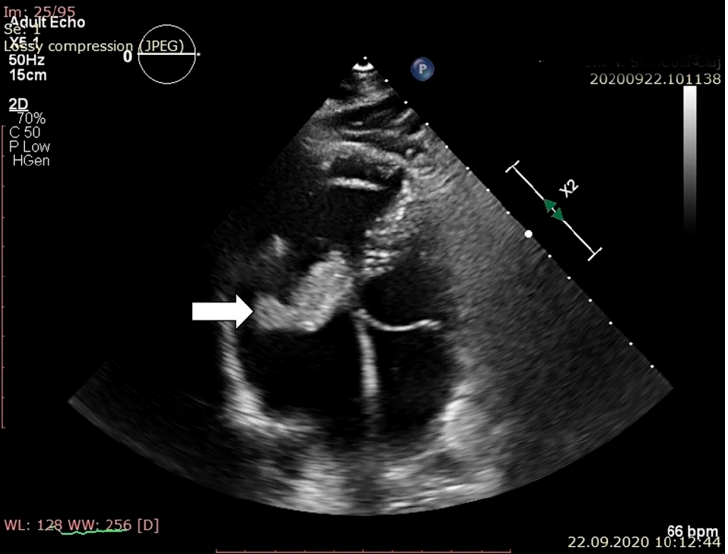
Figure 2. Apical 4 chamber view. Systolic prolapsed in the right atrium of the septal leaflet and vegetation. Laboratory tests revealed a low-grade, chronic inflammation (erythrocyte sedimenta- tion rate) ESR 35 mm/h, C reactive protein CRP 14.92 mg/L, range ≤ 5 mg/L, fibrinogen 411 mg/dL, range 200–400 mg/dL), leukocytosis (white blood cell WBC 11.73 × 10 3 / µ L) anemia (Hb 9.8 g/dL), thrombocytopenia (26,000/ µ L then 18,000 µ L), a prolonged partial thromboplastin time (APTT 46.9 s, range ≤ 36 s), elevated D-dimers (1278 ng/mL, range <250 ng/mL), positive ACL and anti-beta2 glycoprotein (A β 2GPI) antibodies (256 U/mL, range <20 U/mL) and lupus anticoagulant (LA), ANA 1/320 with a speckled pattern, a neg- ative ANA extensive panel, and low C3 complement (71 mg/dL, range 90–120 mg/dL). Two blood cultures were positive for A. defectiva identified using the VITEK2 Compact analyzer (bioMerieux, Marcy-l’ É toile, France). Serology was also positive for C. burnetii anti-phase II IgG (1/128) and phase I IgG (1/1024) antibodies. Repeated RT-PCR (real-time poly- merase chain reaction) for SARS-CoV2 and anti-SARS-CoV2 IgM and IgG antibodies were negative. She received ceftriaxone 4 g/day for 2 weeks, then vancomycin 30 mg/kg/day in 3 doses for 6 weeks, combined with aminoglycoside (gentamycin 3 mg/kg /day